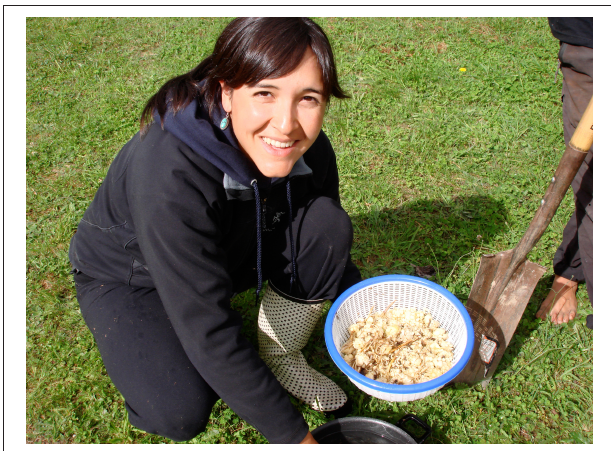
FIGURE 3 | Styawat with lhásem (northern